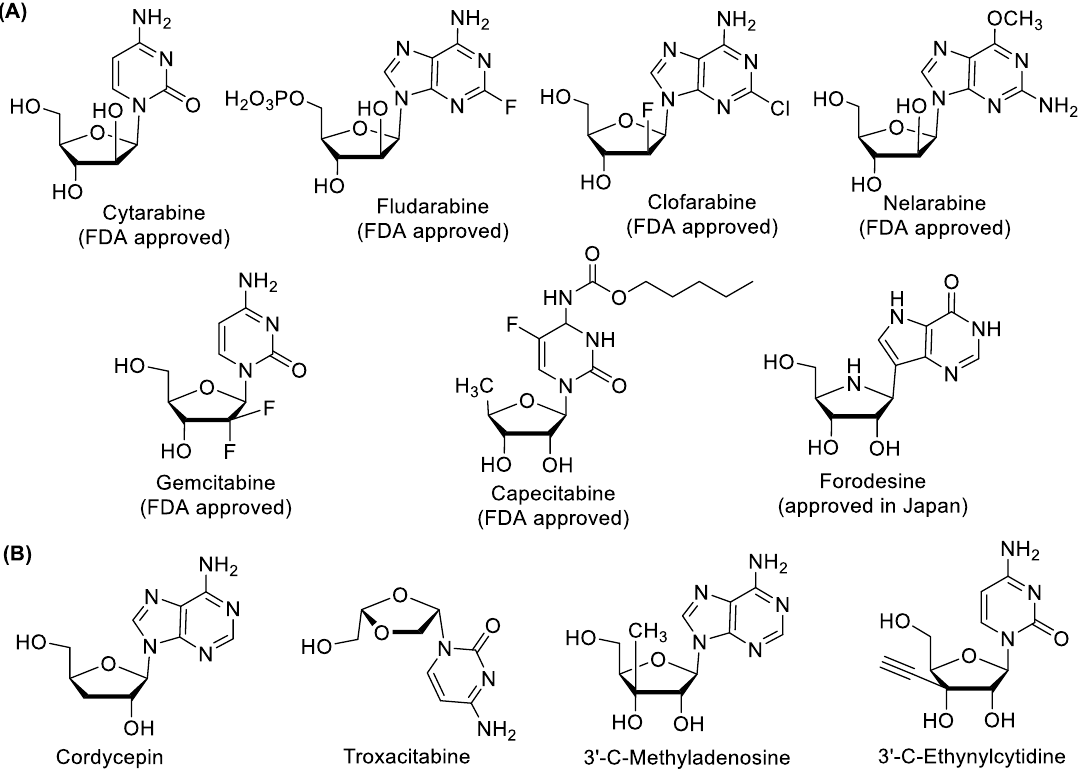
Figure 1. Sugar modified nucleosides as approved ( A ) or clinically investigated ( B ) anticancer agents .